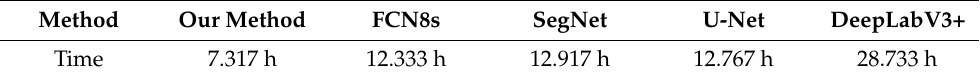
Table 7. Time spent for PV panel extraction on the test area by different